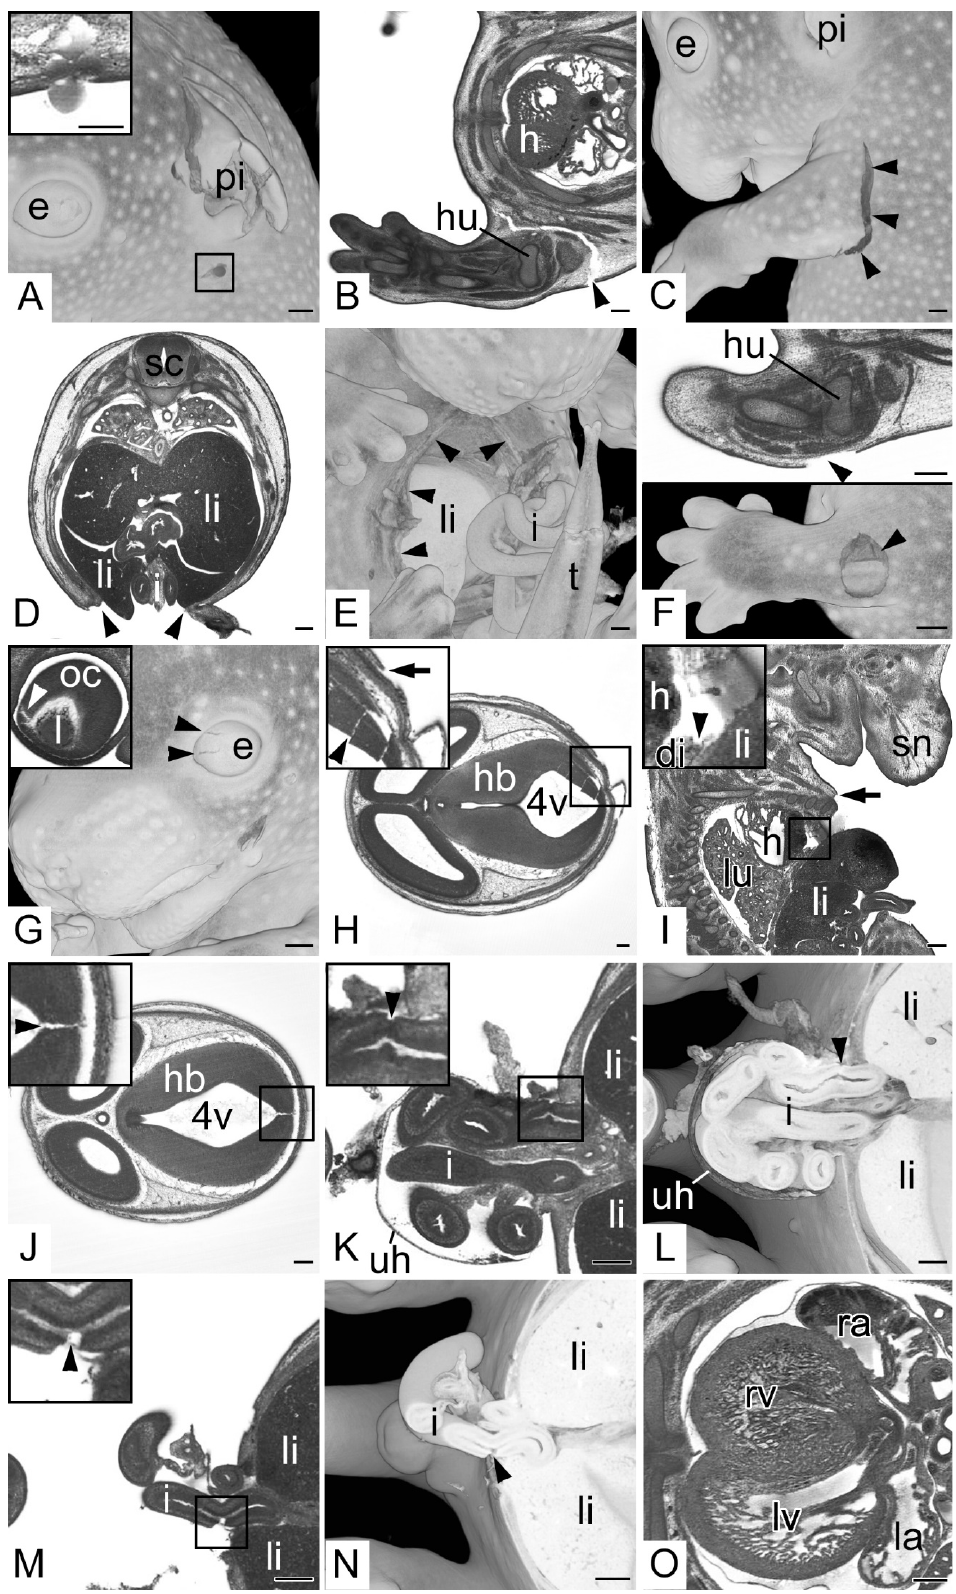
Figure 2. Specimen harvesting artefacts. ( A ) Semitransparent volume model of the head from the left. Pinna (pi) broken. Box indicating puncture damage. Inlay: transverse HREM section showing puncture damage. ( B , C ) Torn upper left